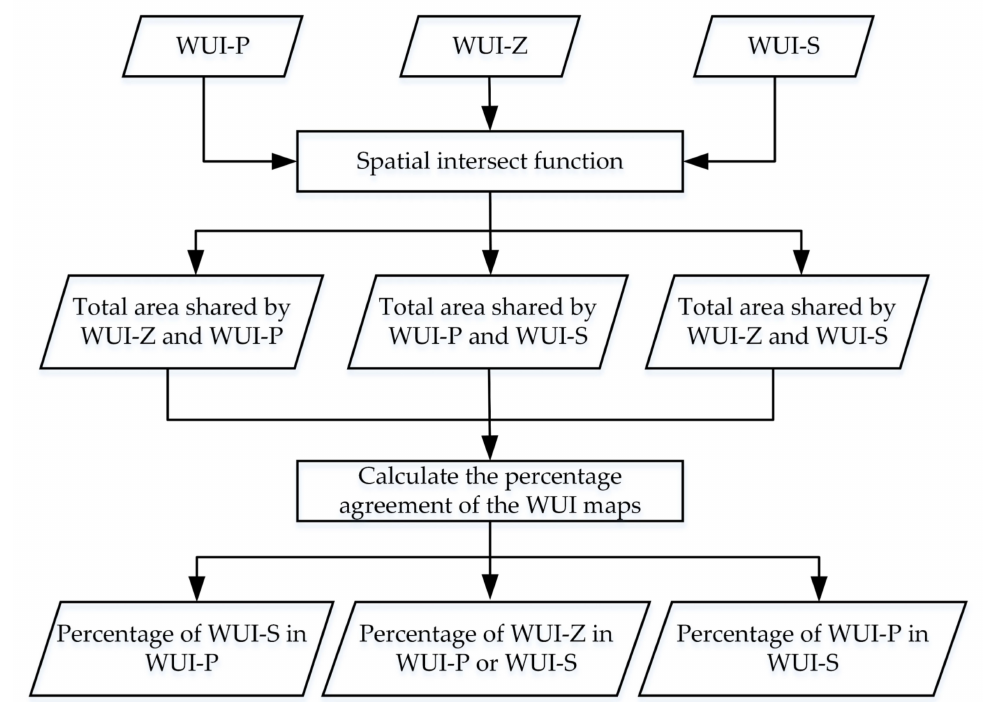
Figure 3. The flowchart of the WUI mapping